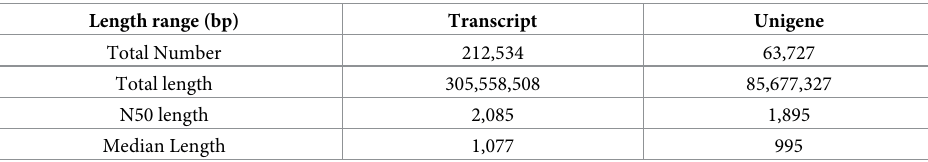
Table 1. Summary of the trinity assembly for Rosa roxburghii